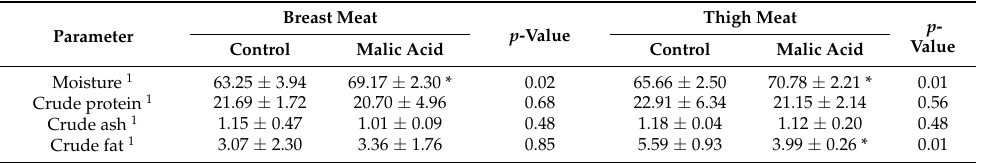
Table 3. Chemical composition (%) of breast and thigh meats from broilers receiving malic acid- supplemented drinking water at slaughter